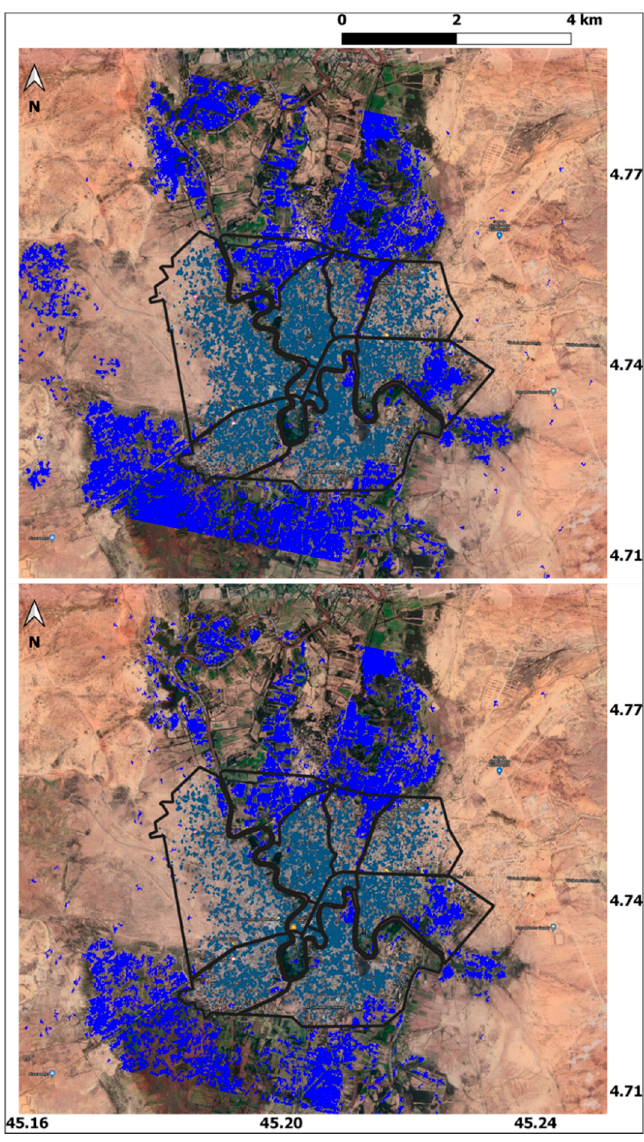
Figure 8. Maps of flooded areas for 30 October, 2019 (top panel) and 21 May, 2020 (bottom panel). Dark blue: rural/suburban areas; light blue: flooded PSs. The boundaries of the districts shown in Figure 1 are highlighted in black.